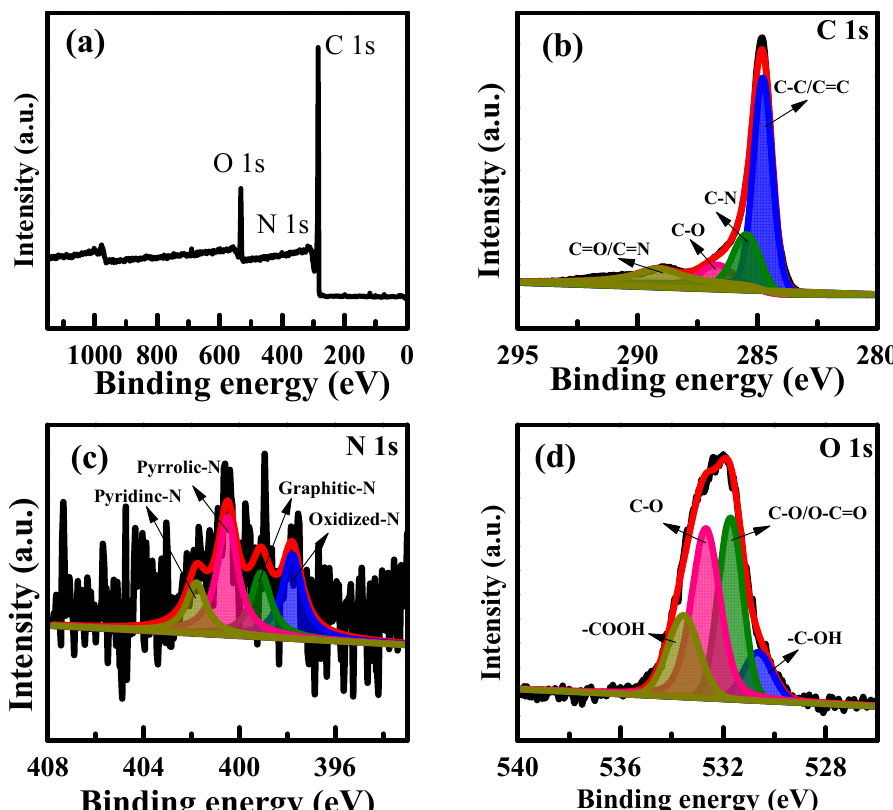
Figure 3. XPS analysis of FWRA sample: ( a ) Survey scan; ( b ) C1s; ( c ) N1s and ( d ) O1s.